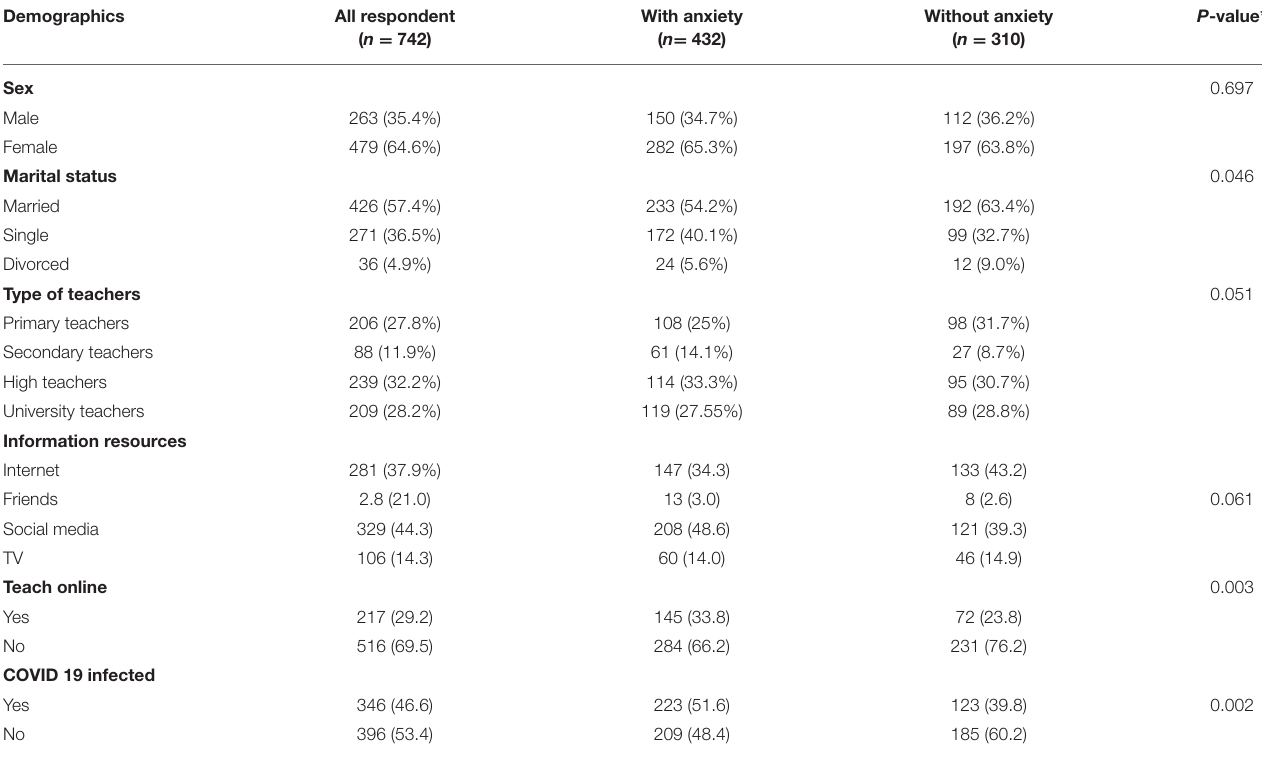
TABLE 1 | Demographics of the teachers based on their anxiety